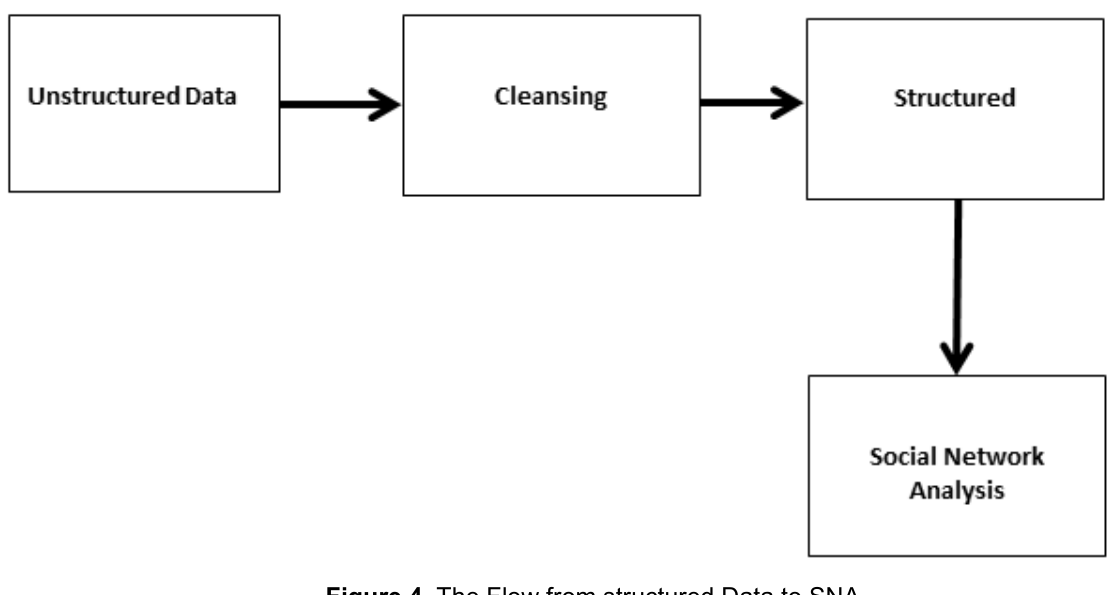
Figure 4. The Flow from structured Data to